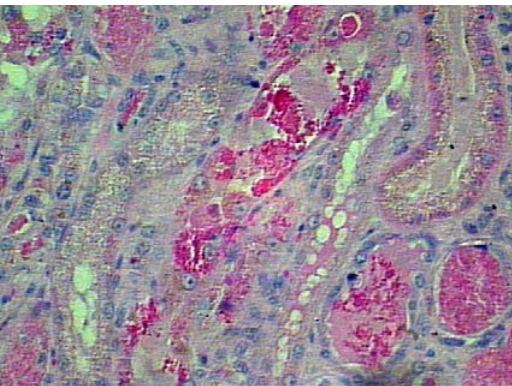
Figure 4. Histological section of renal tubules: tubular hydropic degeneration and necrosis; and necrotized cells in the lumen (hematoxylin and eosin stain, 400x).